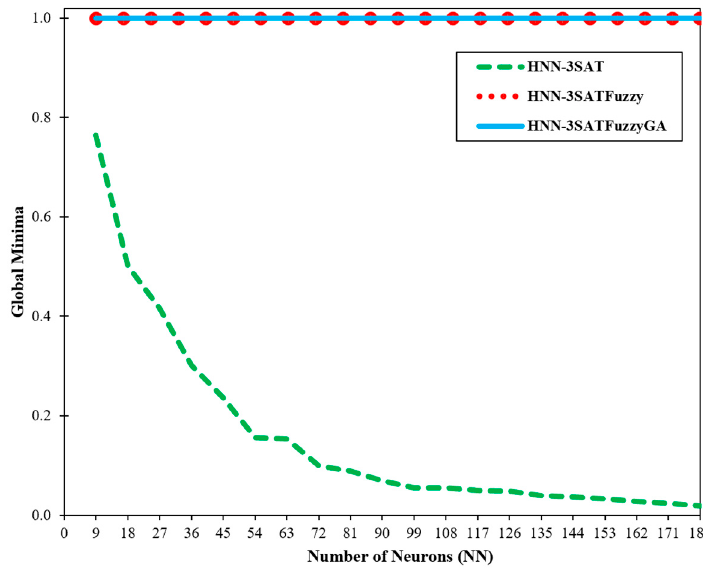
Figure 7. Global minima ratio (zM).